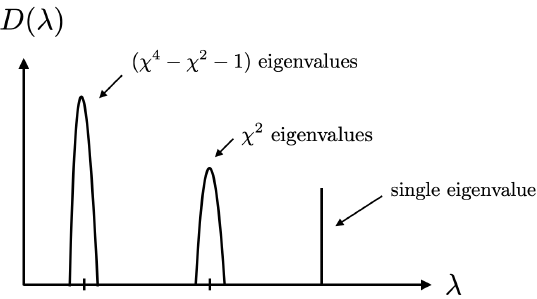
Figure 15 . The spectrum obtained from the resolvent eq. (3.90). We take χ A < χ B here so the MP distribution has no zero eigenvalues.